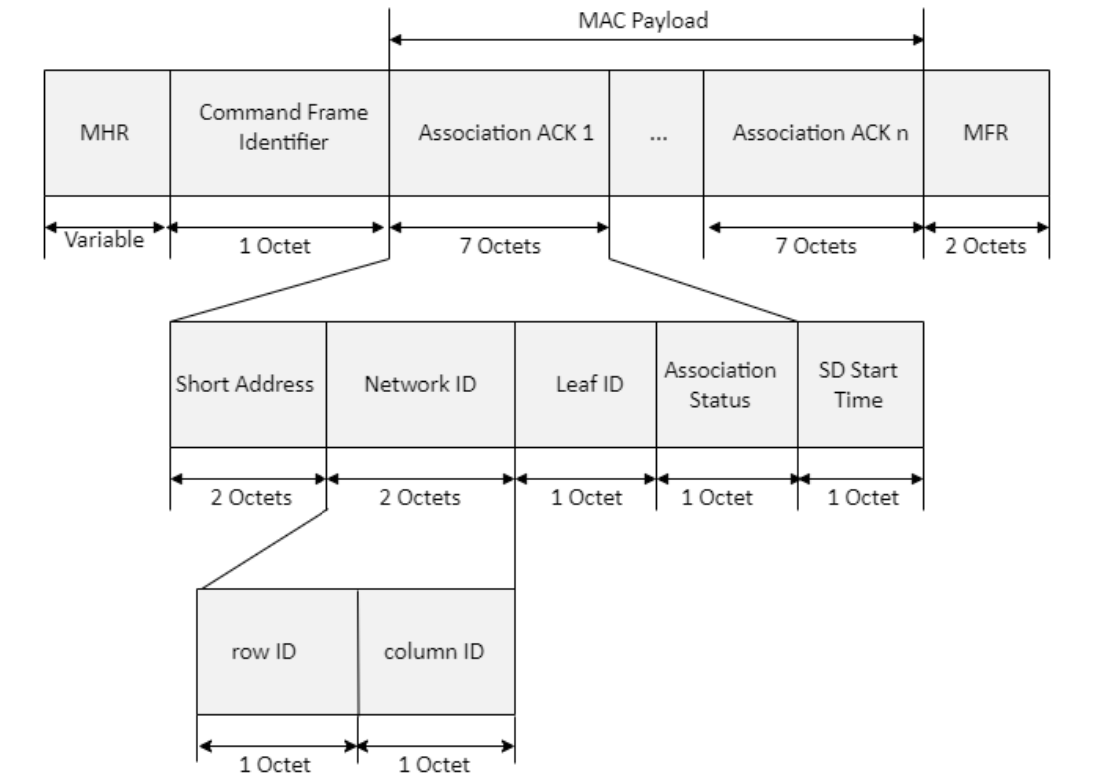
Figure 7. Format of the proposed association-response frame.